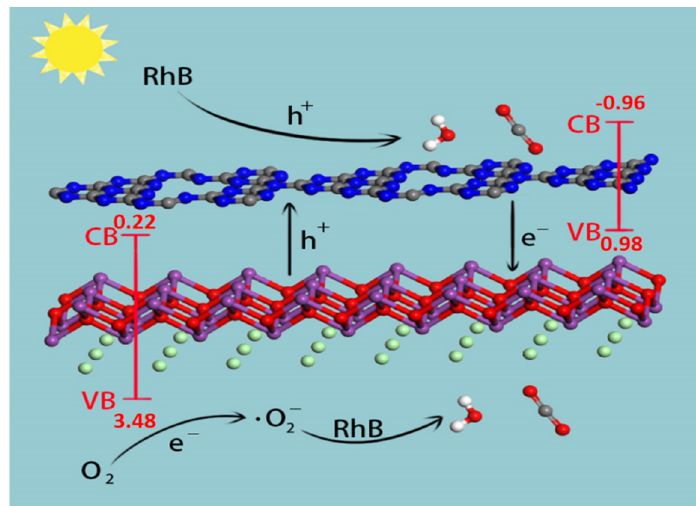
Figure 11. Plausible mechanism for the degradation of